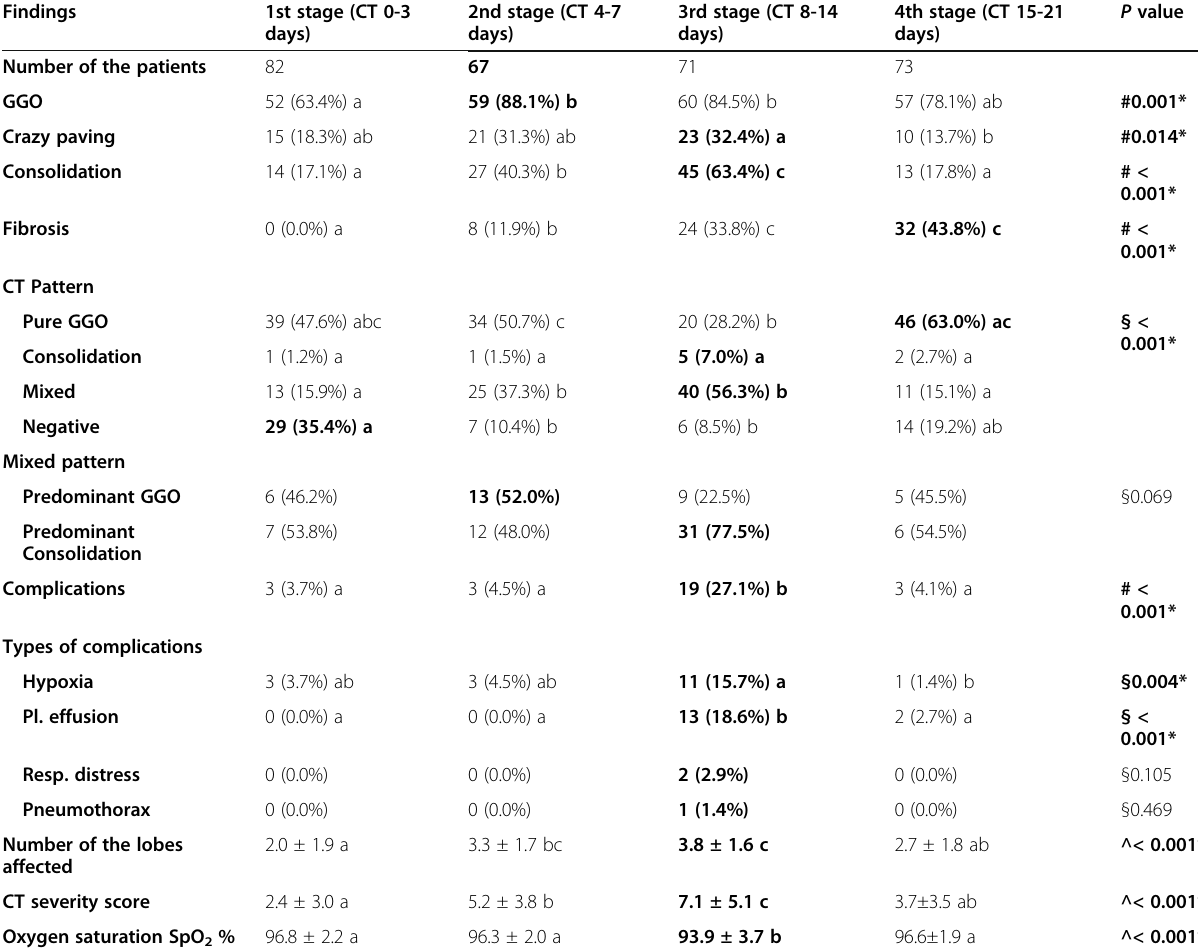
Table 2 The CT changes, CT pattern, CT severity score, complications, and oxygen saturation that occurred during different stage of the COVID-19